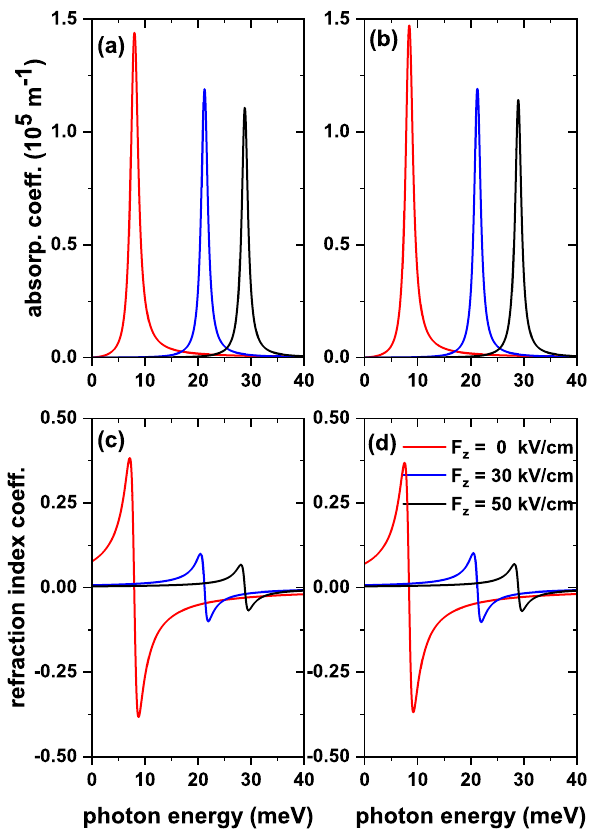
Figure 10. The total optical absorption coefficient ( a , b ) and relative changes in the total refractive index coefficient ( c , d ) as a function of the energy of the incident photon in a ZnS/CdS/ZnS spherical QD, for three values of the electric field: zero, 30kV/cm, and 50kV/cm. The results are without ( a , c ) and with ( b , d ) donor impurity at the QD center. Calculations are for R 1 = 4nm, R 2 = 11nm, and R 3 = 12nm. The optical transition is between the states | 1 (cid:105) → | 2 (cid:105) , with m = 0 and without external magnetic field